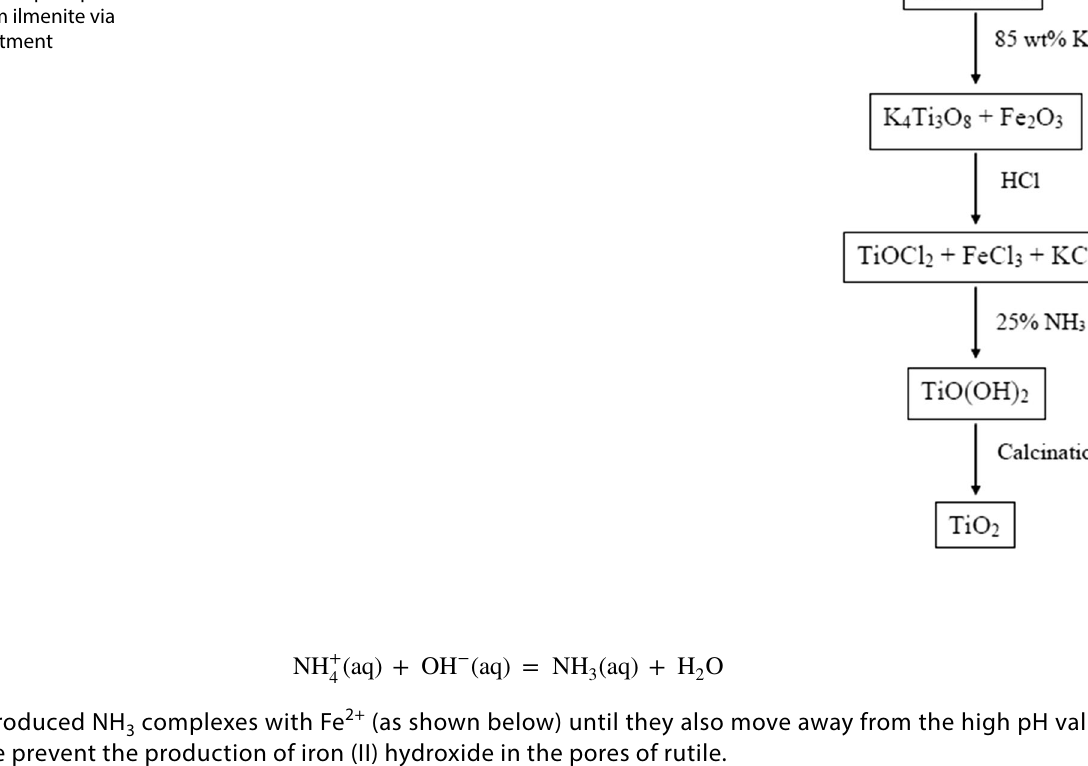
Fig. 9 A flow chart represent- ing the main steps in produc- ing TiO from ilmenite via 2 alkaline